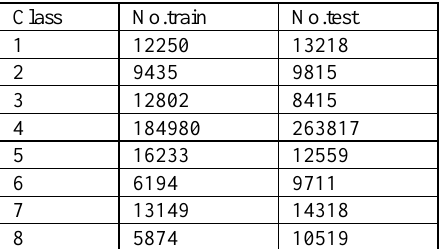
Table 3. Number of train and test samples